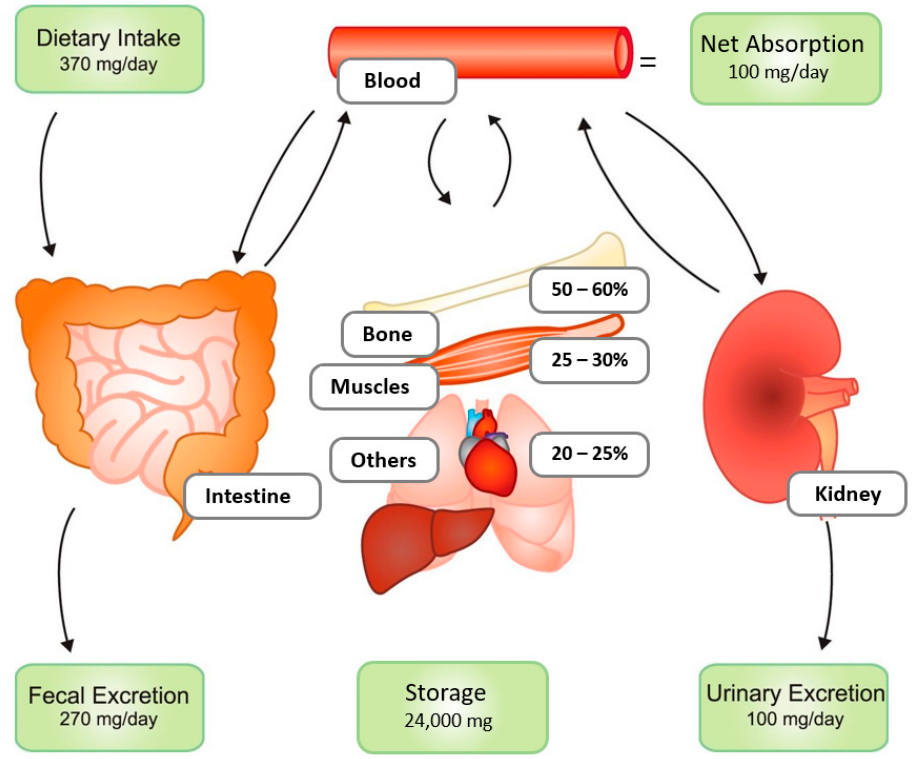
Figure 1. Magnesium (Mg) homeostasis. Panels represent the daily amount of Mg intake and excretion. Daily, the intestines absorb ~120 mg and secrete 20 mg of Mg, resulting in a net absorption of 100 mg. In the kidney daily, ~2400 mg Mg is filtered by the glomerulus, of which 2300 mg is reabsorbed along the kidney tubule. This results in a net excretion of 100 mg, which matches the intestinal absorption. Bone and muscle provide the most important Mg stores. Reproduced with permission [2]. Copyright 2015, the American Physiological Society.